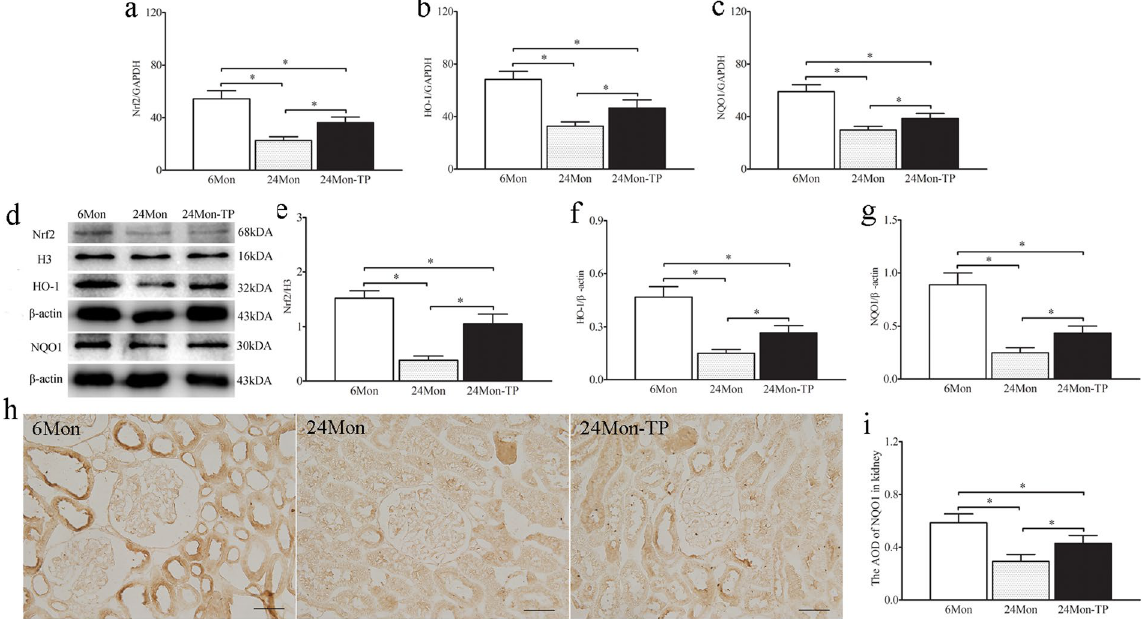
Figure 7. The effects of TP on Nrf2-ARE signaling in the renal tissue of aged rats. Bar graphs showed Nrf2 mRNA ( a ), HO-1 mRNA ( b ) and NQO1 mRNA ( c ). ( d ) Western blot study revealed Nrf2, HO-1 and NQO1 expression in the renal tissue. Bar graphs illustrated the protein expression of Nrf2 ( e ), HO-1 ( f ) and NQO1 ( g ). ( h ) Immunohistochemistry revealed the variation of NQO1 immunoreactive intensity. Bar = 500 nm. ( i ) Bar graph showed the AOD of NQO1. The asterisks show significant differences ( * P < 0.01).